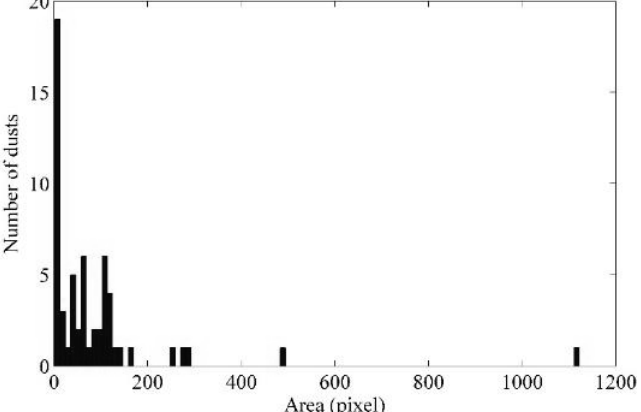
Figure 5. An example of a dust amplitude spectrum for a captured